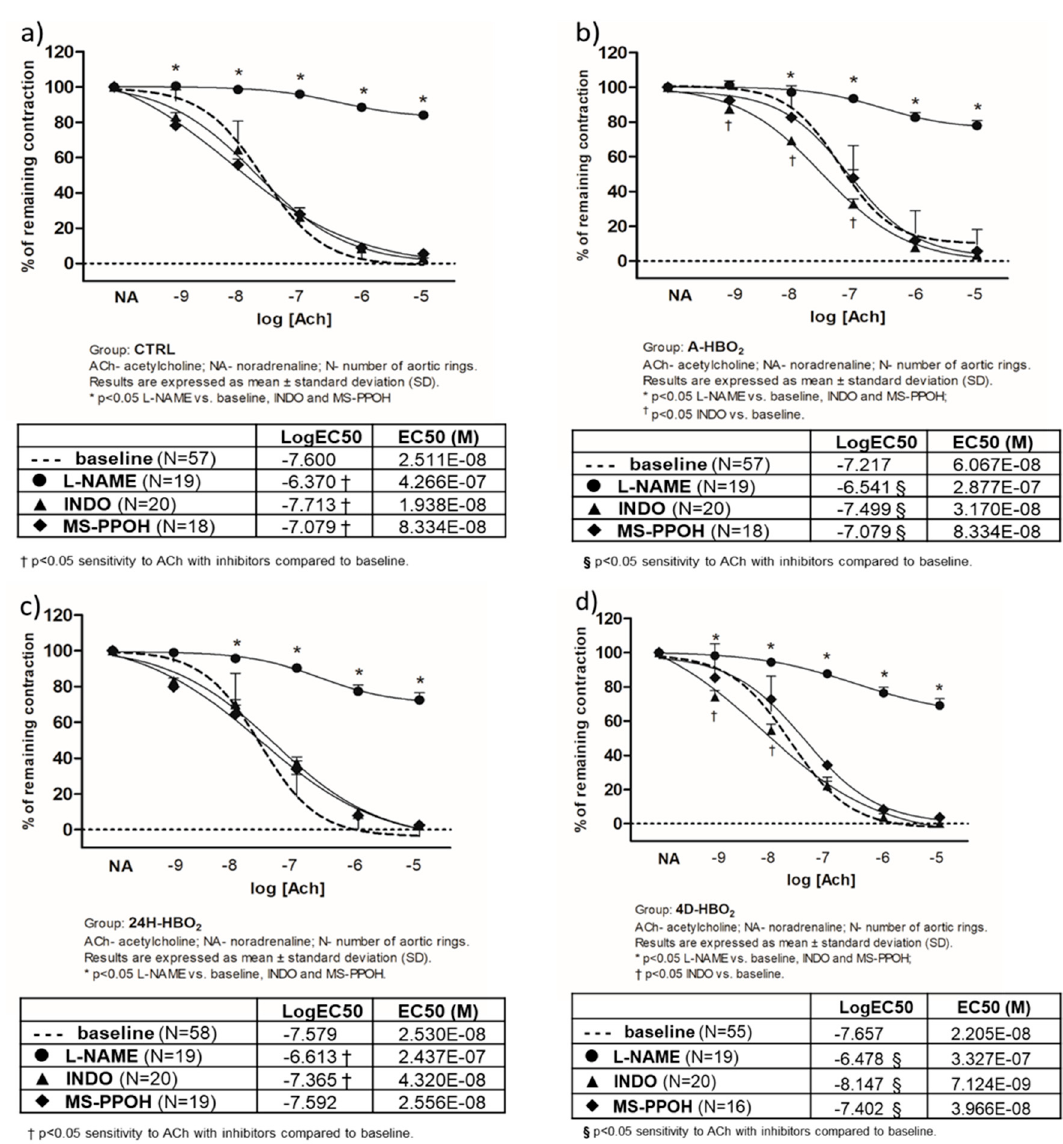
Figure 2. Mechanisms of AChIR response of isolated rat aorta rings in CTRL ( a ), A-HBO 2 ( b ), 24H-HBO 2 ( c ) and 4D-HBO 2 ( d ) groups of rats with and without inhibitors (L-NAME, INDO, MS-PPOH). Results are presented as mean ± SD; N – number of aortic rings; p < 0.05.